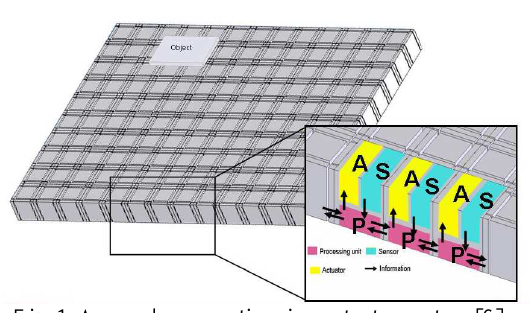
Fig. 1. Arrayed pneumatic microactuator system [6]